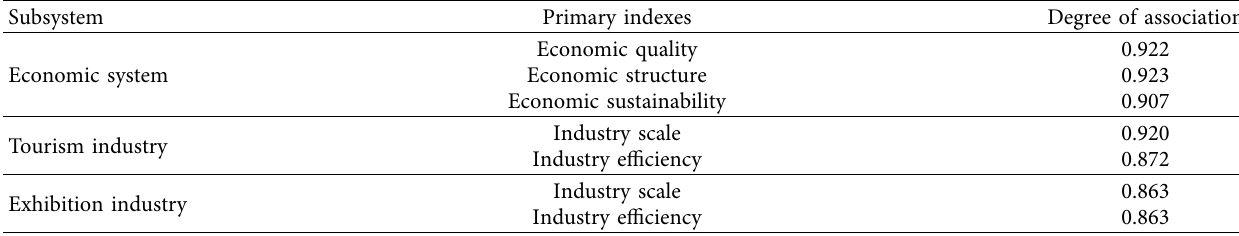
Table 3: Results of gray correlation analysis of measurement of primary indexes.